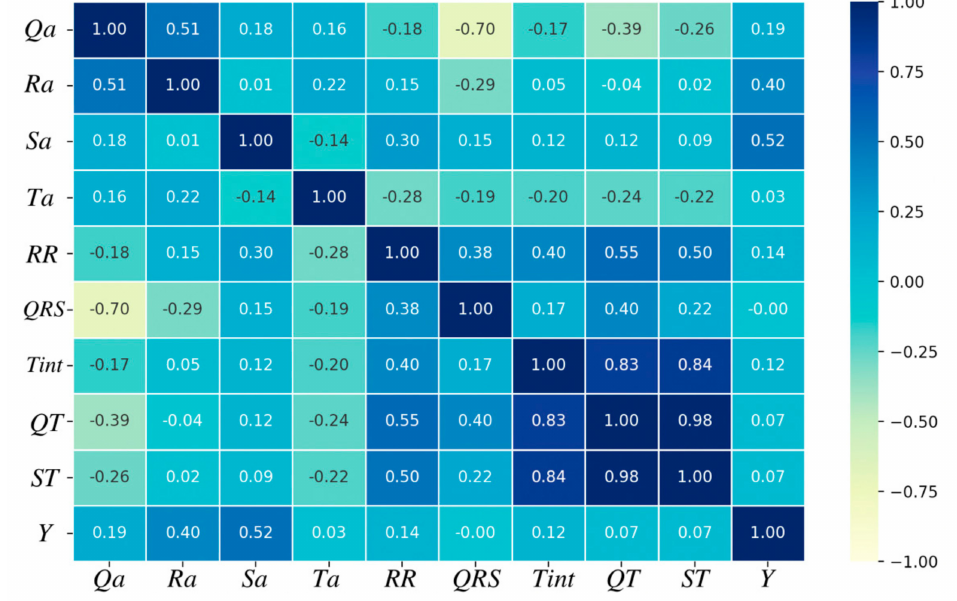
Figure 3. Histograms and scatter plots of ECG signal parameters in different states.